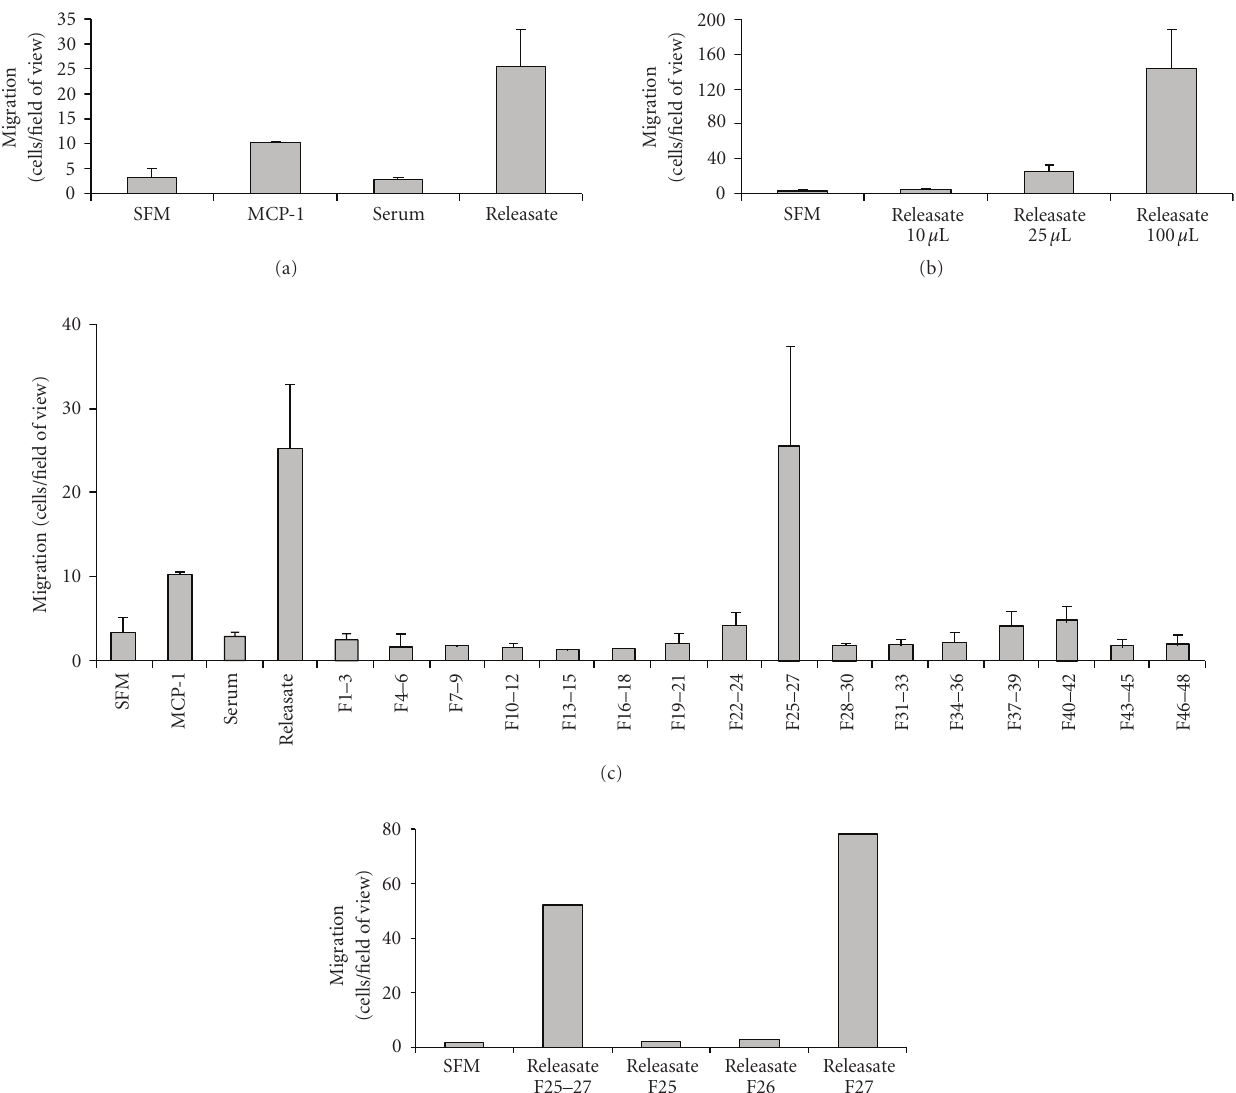
Figure 2: A pro-migratory e ff ect identified in unfractionated and fractionated platelet releasate. THP-1 monocyte cell migration was measured using a Boyden chamber assay over 2 hours. (a) Assessment of migrated cells adhering to the underside of the membrane in response to platelet releasate, Serum (10%), and MCP-1 (100ng/mL). N = 3; (b) Adherent migrated THP-1 cells in response to 10, 25 or 100 μ L platelet releasate; N = 3. (c) Fractions were pooled in groups of three and added to serum-free media (SFM) in the bottom chamber. Positive controls include MCP-1 and unfractionated platelet releasate; N = 3. (d) Localisation of the pro-migratory e ff ect of Fractions 25–27 to an individual fraction. Each fraction (2 μ L) was added to serum-free media in the bottom chamber of a separate well and compared with the combination of Fractions 25–27 (2 μ L of each fraction). TRAP = thrombin receptor-activating peptide. N = 3. The average number of migrated cells adhering to the underside of the membrane was calculated from ten 40X fields of